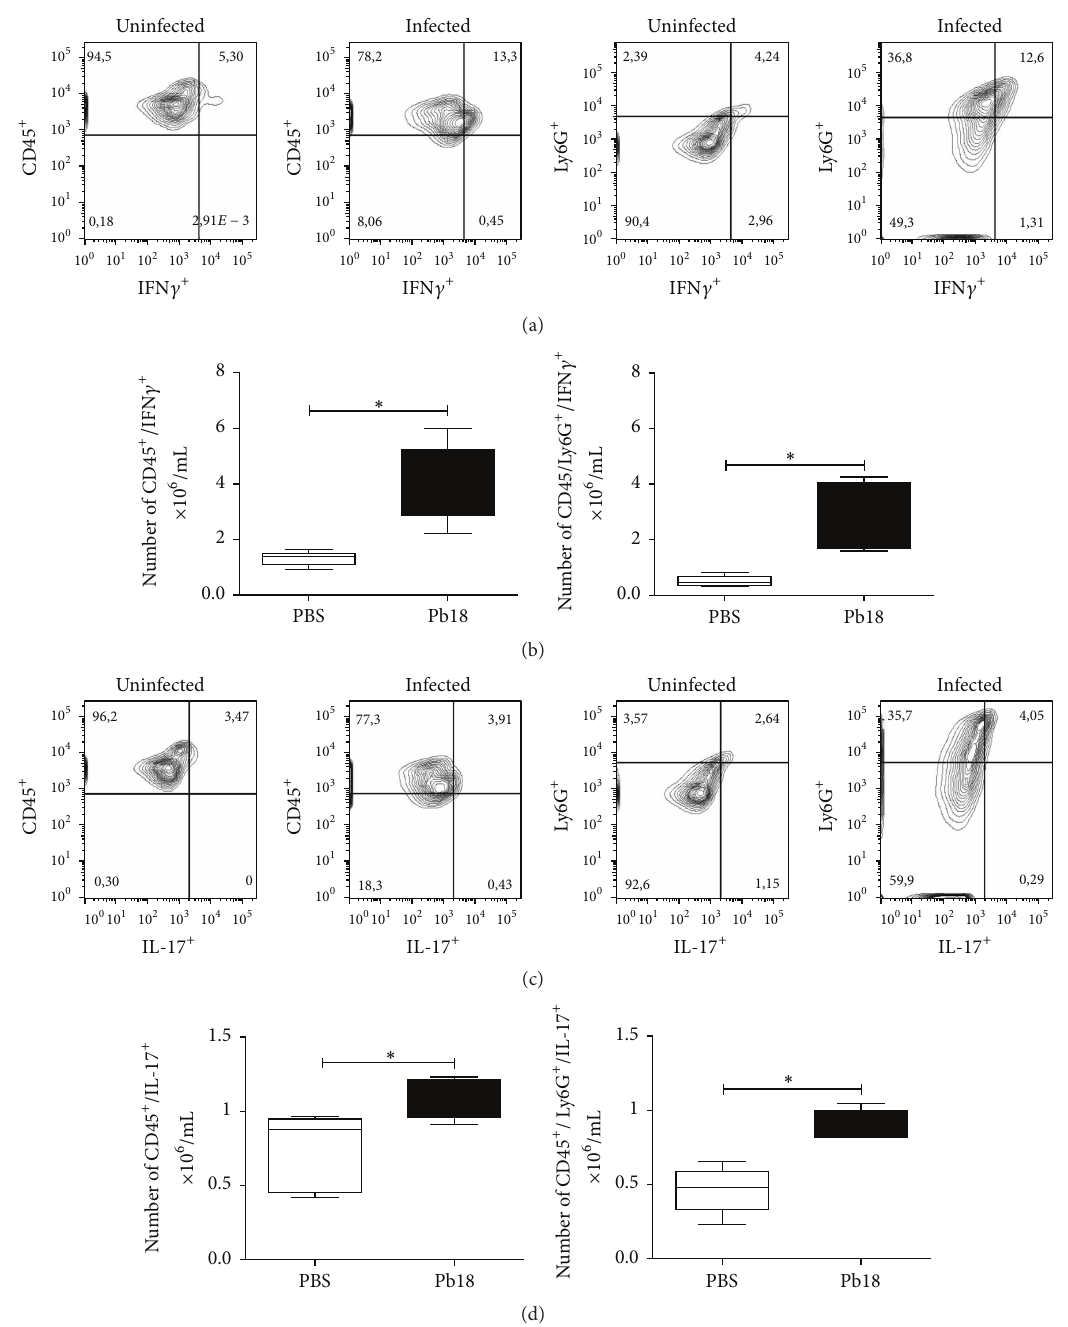
Figure 6: Neutrophils are an important source of IFN- 𝛾 and IL-17. BALB/c mice were intranasally inoculated with PBS or 1.5 × 10 6 P. brasiliensis (Pb18) yeast cells and analyzed during the acute phase of P. brasiliensis infection (96h postchallenge). (a) Representative flow cytometry contour plots of CD45 + - and neutrophils- (CD45 + /CD11b + /Gr1 + /Ly6G + -) IFN- 𝛾 -producing cells subpopulations at 96 h after infection are shown. Numbers inside the gates indicate the mean percentages of the gated subsets. (b) Bar plots of CD45 + - and neutrophils- (CD45 + /CD11b + /Gr1 + /Ly6G + -) IFN- 𝛾 -producing cells per lung. (c) Representative flow cytometry contour plots of CD45 + - and neutrophils- (CD45 + /CD11b + /Gr1 + /Ly6G + -) IL-17-producing cells subpopulations at 96 h after infection are shown. Numbers inside the gates indicate the mean percentages of the gated subsets. (d) Bar plots of CD45 + - and neutrophils- (CD45 + /CD11b + /Gr1 + /Ly6G + -) IL-17-producing cells per lung. Data shown represent median and IQR ( 𝑛 = 4 -5 mice/group; representative of two independent experiments). ∗ 𝑃 < 0.05 comparing infected versus control mice. PBS, control mice; Pb18, infected